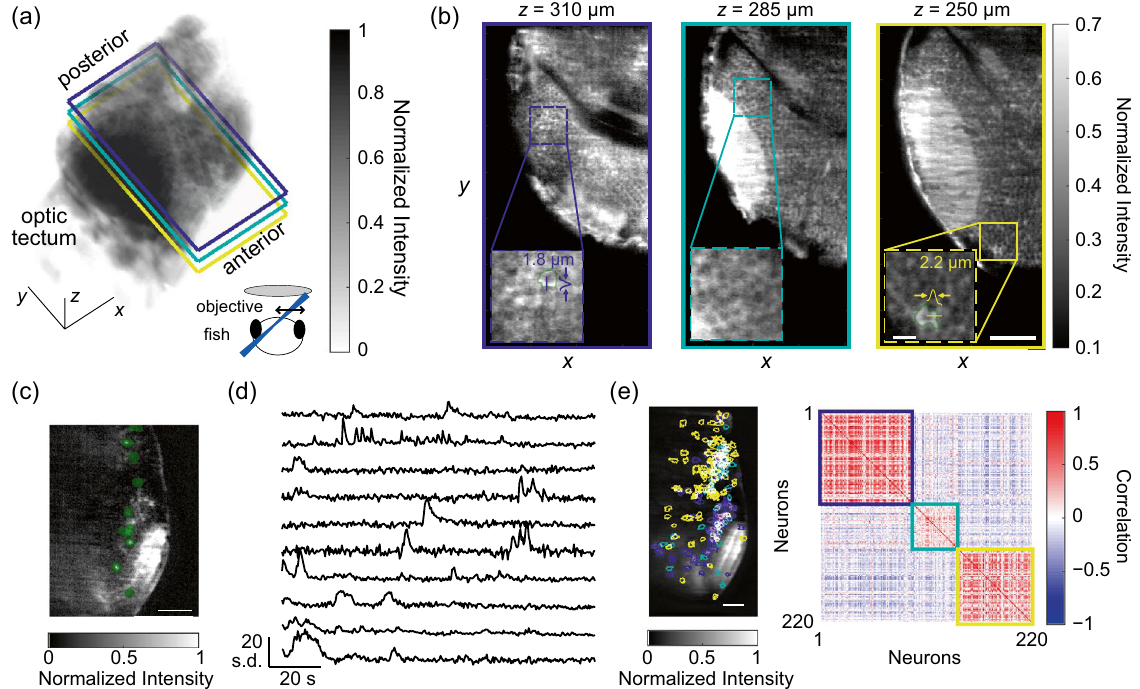
Figure 4. Water-coupled SCAPE revealed sub-cellular structure and dynamic calcium activity of larval zebrafish. ( a ) Three-dimensional rendering of one side of a zebrafish forebrain expressing GCaMP6s revealed the dense connections within the optic tectum. The scale bars along the axes are 50 µm. The volume was obtained with 0.5 µm between layers, and an exposure time of 30 ms per layer. Bottom right inset : We show the fish viewed from the frontal direction, along with the relative orientations of the primary imaging objective and excitation light sheet ( blue ). ( b ) Individual planes color matched to the planes marked in ( a ) revealed sub- cellular structure. This zebrafish line localized GCaMP to the extranuclear space, and neurons appeared as rings in the zoomed-in insets. The scale bar in the large images are 50 µm, while the scale bar in the insets are 10 µm. The green outlines in the insets highlight a clear neuron with ring-like expression pattern. The color profiles show the fluorescence intensity along the straight lines; the arrows note the FWHM of the profiled feature. ( c ) A maximum projection at one imaged slice in a zebrafish over two minutes of imaging shows active neurons. Green outlines represent individual neurons found by our analysis pipeline. We obtained these images with 2.6 µm between layers, and an exposure time of 4 ms per layer. ( d ) Activity from heavy green outlines in ( c ) revealed dynamic and independent activity from individual neurons with high peak to background ratio. The volumetric acquisition rate was 10 Hz. The scale bar is 50 µm. ( e ) Left : The average of the maximum projections of fluorescence from all layers of the same fish as in ( d ) showed all neurons simultaneously. Outlines showed all neurons from all layers simultaneously. The scale bar is 50 µm. Right : The correlation between neurons revealed clusters of neurons that had similar activity, as highlighted by the block diagonal structure of high correlation. The outlines over each block are color matched to the neuron outlines of the left panel. We observed that the cluster of purple neurons localized to the forebrain, and likely resulted from spontaneous visual response. The other two clusters, teal and yellow, localized to the cerebellum and